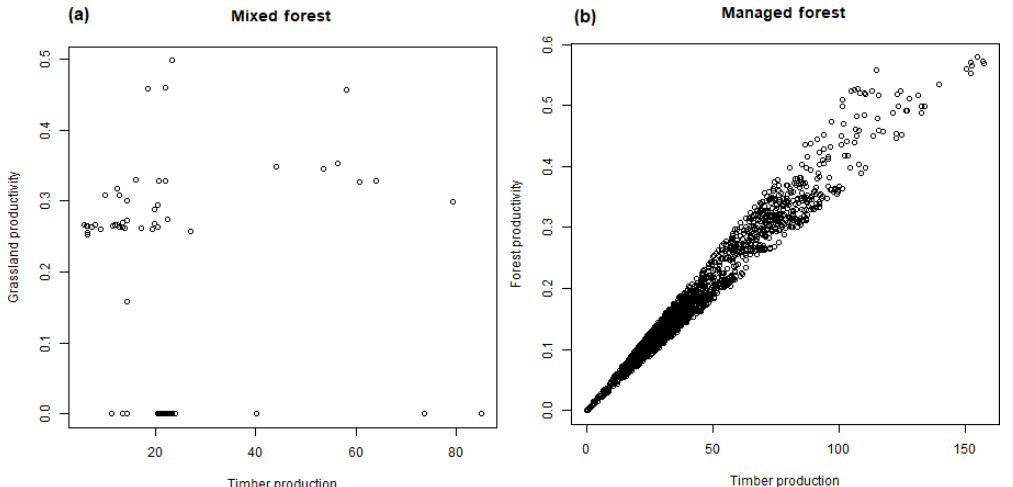
Figure A1. Example capital–service relationships in IAP output data used to quantify the capital sensitivities for AFTs in CRAFTY-EU. Timber production by mixed forest agents (a) is found to be almost completely insensitive to grassland productivity capital, giving a λ c,t value of 0, while timber production by managed forest agents (b) is highly sensitive to forest productivity, giving a λ c,t value of 1.